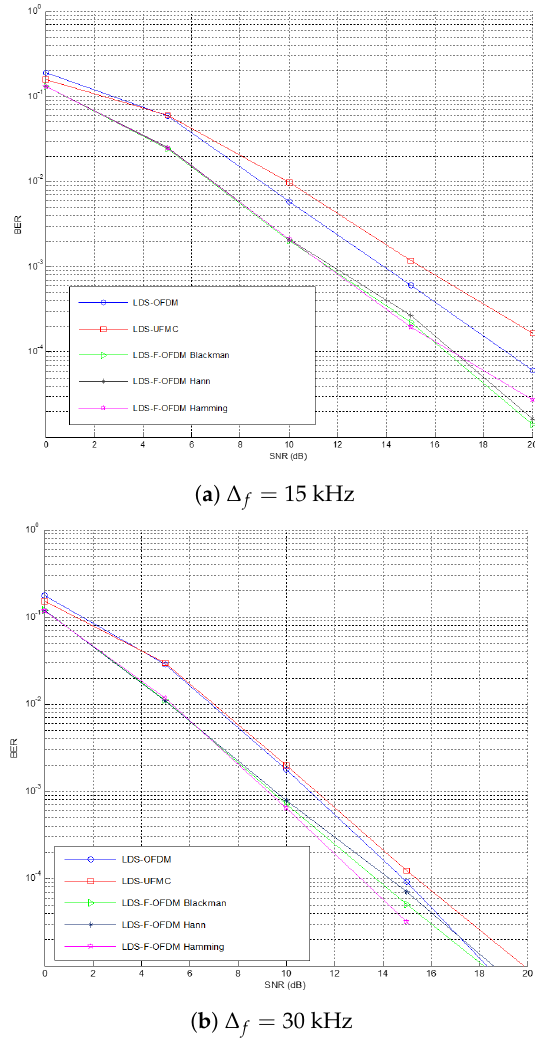
Figure 4. Performance of the proposed schemes over a Tapped Delay Line (TDL)-A